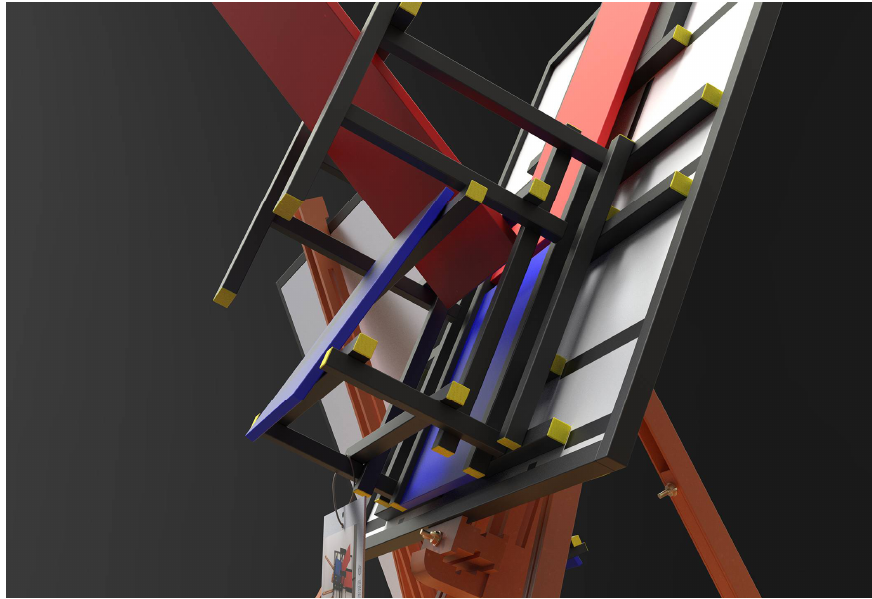
Figure 10. Michelangelo Lamonaca and Martina Carlini: